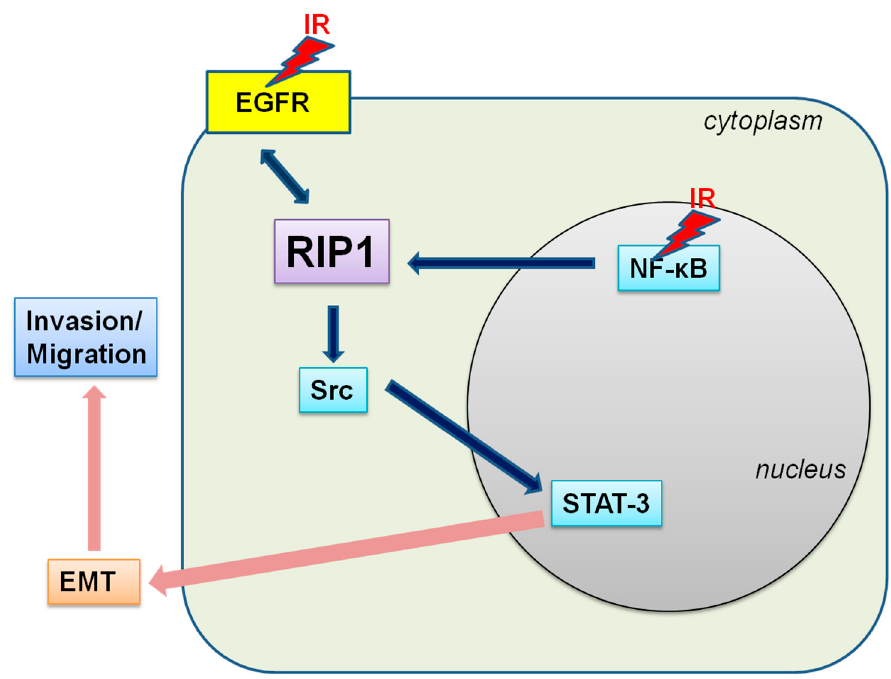
Figure 7. Scheme of the potential IR-induced EGFR/NF- κ B–RIP1–Src–STAT3–EMT pathway.